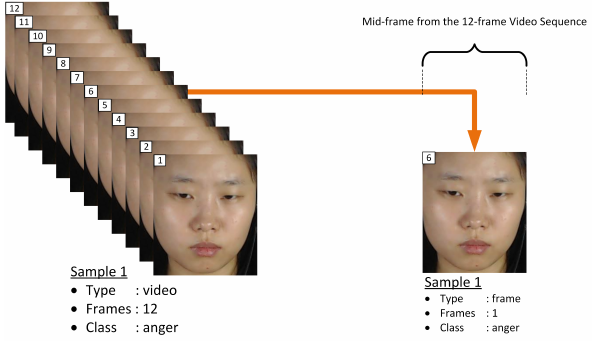
Figure 4. Illustration of video to frame sampling for Experiment I.